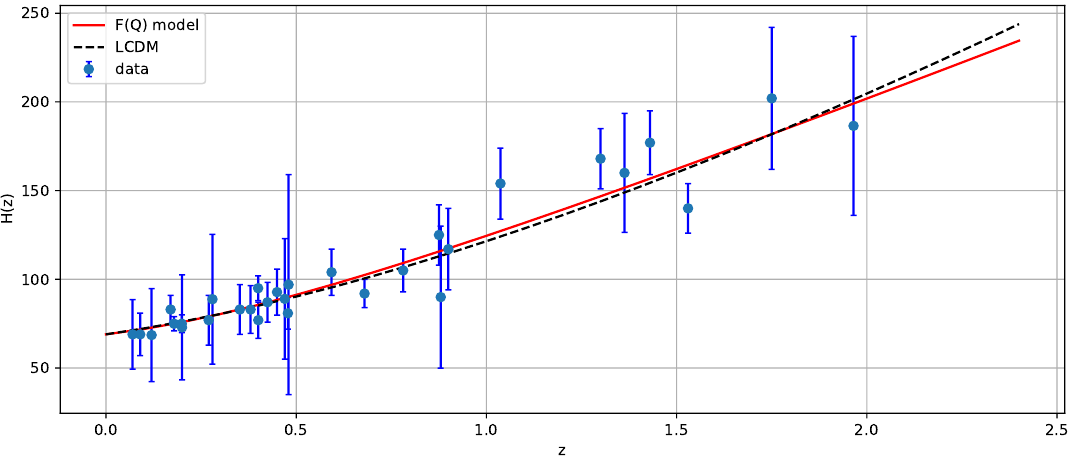
Figure 1. The error bar plot of H versus z for the considered f ( Q ) model. The solid red line is the curve for the f ( Q ) model, whereas the black dotted line represents the Λ CDM model. The blue dots depict the 31 points of the Hubble